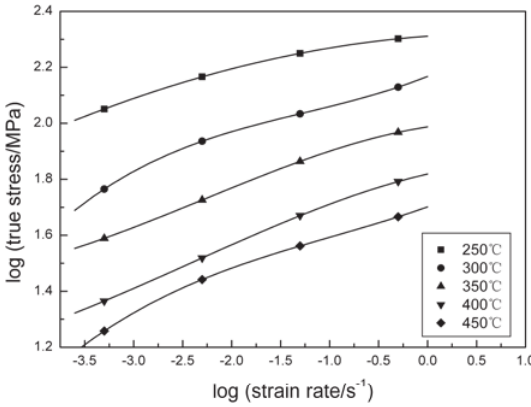
Fig. 4: Fitting curves to describe the relationship between log (true stress) and log (strain rate) for a strain of 0.7.